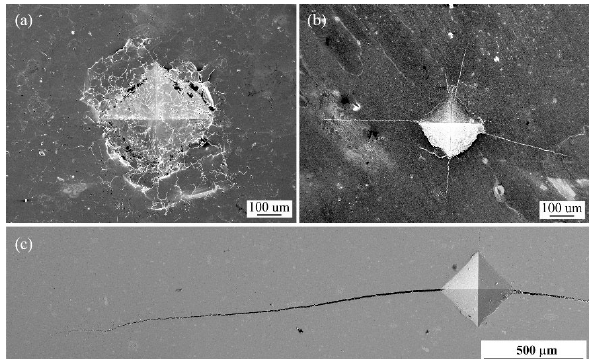
Fig. 36 Morphologies of Vickers indentation of untextured and textured Cr 2 AlC specimens: (a) untextured specimen; (b, c) textured specimen surfaces perpendicular and parallel to the sintering pressure, respectively (the double arrow indicates the pressure direction). Reproduced with permission from Ref. [123], © Elsevier Ltd.